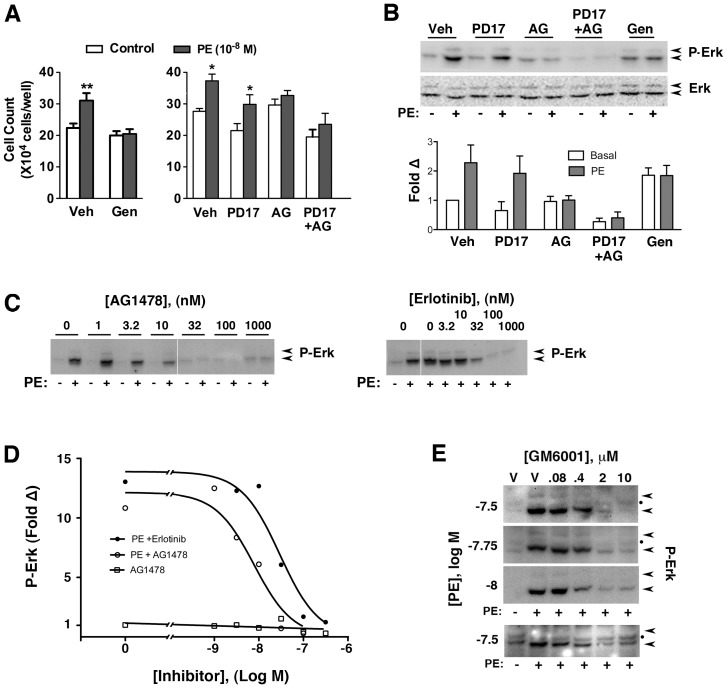
EGFR transactivation through a TMP mechanism is required for low dose α1aAR-induced proliferation and Erk activation.α1aAR expressing cells were placed into SF media prior to pretreament and addition of PE. (A) Prior to counting, cells were pretreated for 30 min with 0.1% DMSO (Veh), 20 µM Genestein, 1 µM PD173704 (PD17), 1 µM AG1478 (AG), 1 µM PD173704+1 µM AG1478 prior to growth without (control) or with 10−8 M PE. Values are the mean±SEM; (*), P<0.05 compared to vehicle or inhibitor alone (n≥3); (**), P<0.05 compared to vehicle+PE. (B) Representative Western analysis of Erk phosphorylation in cells pretreated for 30 min with vehicle 0.1% DMSO (Veh), 1 µM PD17, 1 µM AG, 1 µM PD +1 µM AG or 20 µM genistein (Gen) prior to stimulation without (−) or with (+) PE at 2×10−8 M for 10 minutes. Lower panel shows semi-quantitative analysis of P-Erk band intensity from CCD images. Values are the mean±SEM (n = 4); (*), P<0.05 compared to vehicle or inhibitor alone. (C) Inhibition of Erk phosphorylation by a dilution series of the EGFR inhibitors, AG1478 and Erlotinib, added 5 minutes prior to stimulation with 3×10−8 M PE for 5 minutes. To maintain relative intensity, panels were concordantly adjusted. (D) Quantitation of P-Erk band intensity at the indicated AG1478 and Erlotinib concentrations relative to levels in untreated cells. (E) Top 3 panels shows western analysis of Erk phosphorylation in cells pretreated for 30 min with 0.1% DMSO (Veh) or GM6001 (GM) prior to incubation for 5 minutes without (−) or with (+) PE. The bottom panel shows a similar experiment in which the GM6001 preincubation was ∼15 seconds. Panel adjusted independently to emphasis inhibition pattern. (•) Indicates an artifactual band.